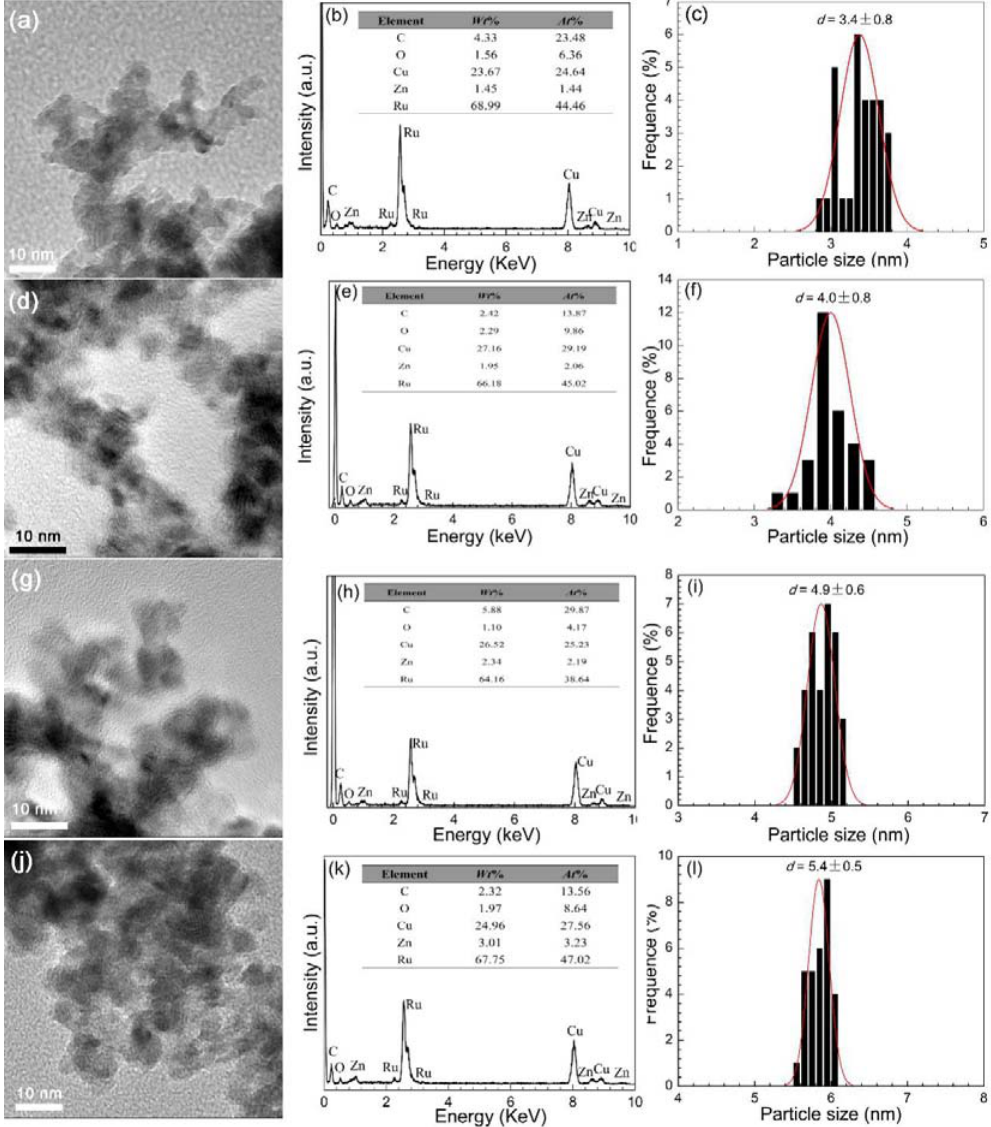
Figure 10. HRTEM images, EDS, and particle size distribution of the Ru catalysts with the different particle size after hydrogenation. First row ( a – c ), second row ( d – f ), third row ( g – i ) and last row ( j – l ) belongs to Ru-3.5 AH, Ru-4.1 AH, Ru-4.7 AH and Ru-5.6 AH, respectively. Table 2. Textural properties of the Ru catalysts with the different particle size before and after catalytic experiments, including specific surface area (S BET ), pore volume (V p ) and pore diameter (d p ). Catalyst S BET /m 2 g − 1 V p /cm 3 g − 1 d p /nm Ru-3.5